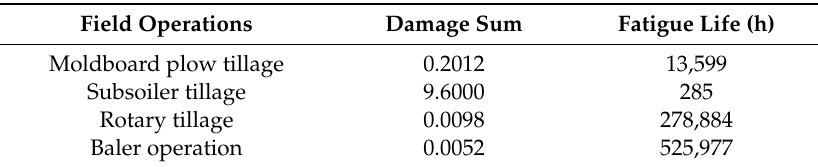
Figure 9. Results of fatigue analysis of spiral bevel gears based on simulation model: ( a ) damage sum and ( b ) fatigue life. Table 7. Damage sum and fatigue life of the spiral bevel gear by each agricultural operation based on our simulation model.